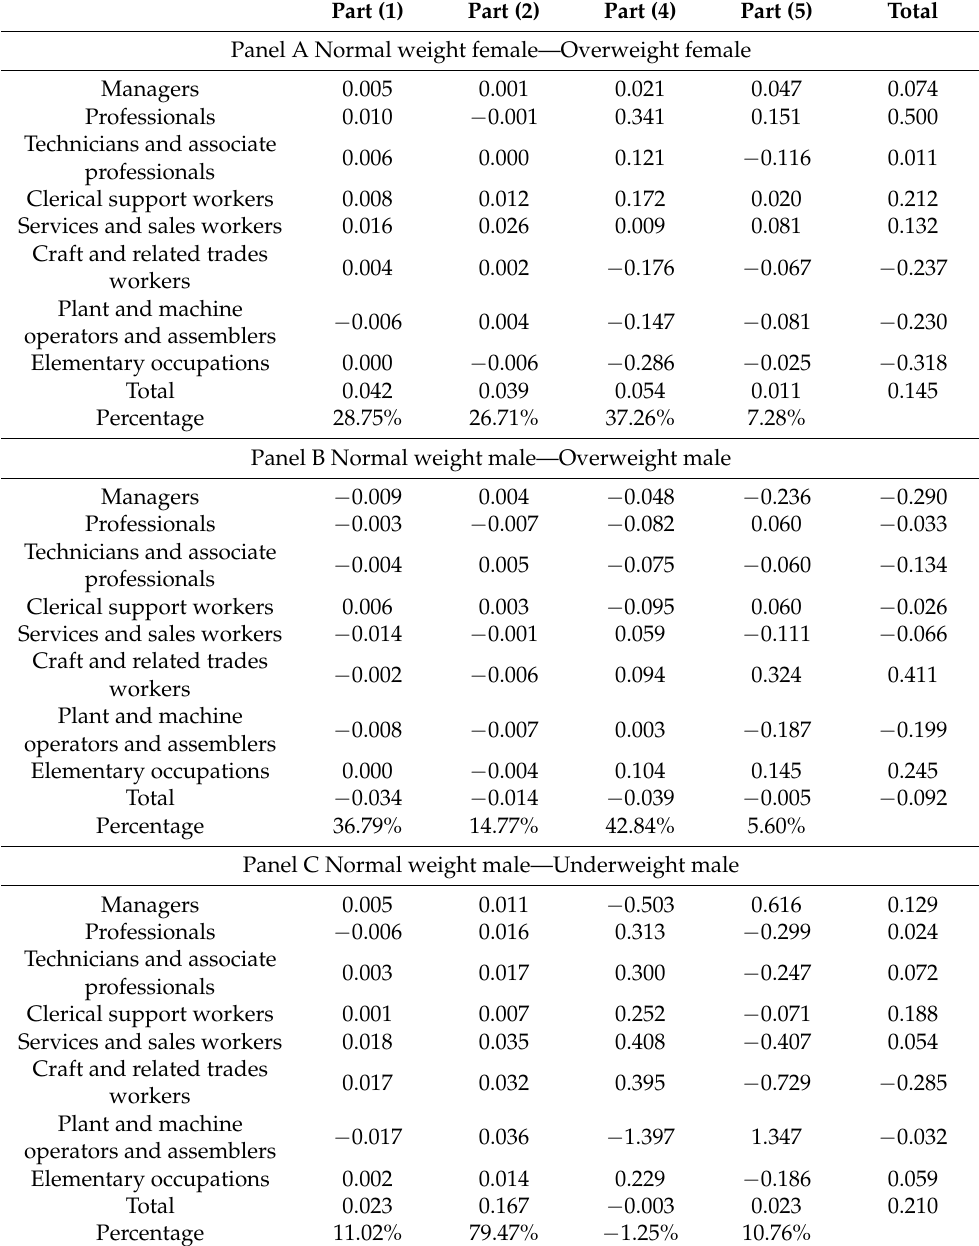
Table 5. Income gap